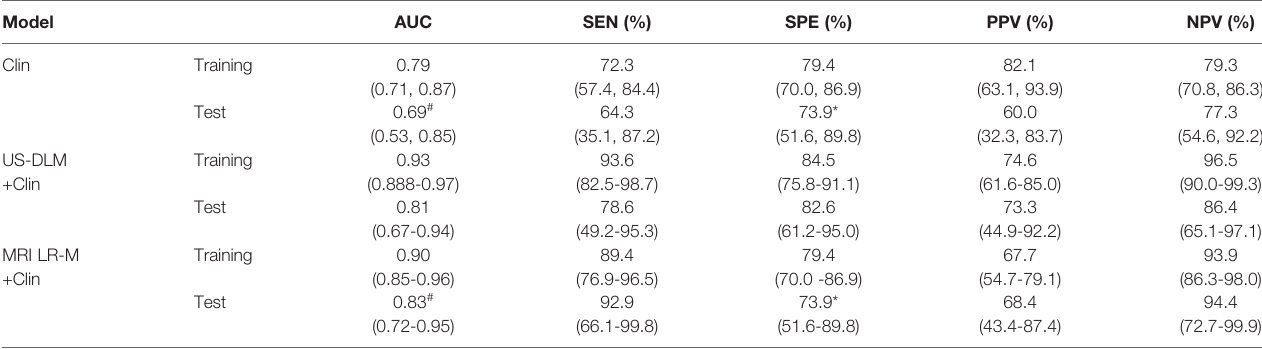
OM,othermalignancy;AUC,areaunderreceiveroperatingcharacteristiccurve;SEN,sensitivity;SPE,speci fi city;PPV,positivepredictivevalue;NPV,negativepredictivevalue;Clin,clinical features; MRI, Magnetic Resonance Imaging; LR-M, liver imaging and reporting system category M; I-Training, internal training; I-Validation; internal